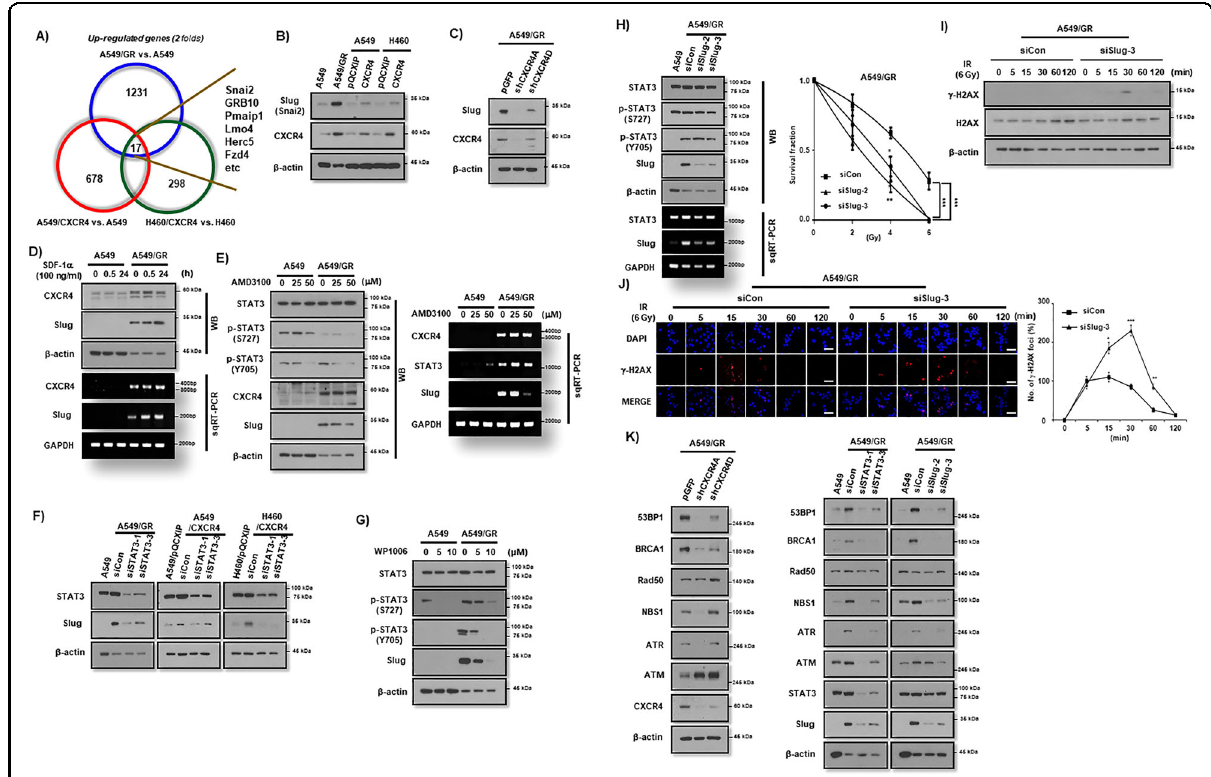
Fig. 5 Upregulation of Slug is responsible for the IR resistance in CXCR4 overexpressed NSCLC cells. A Microarray of NSCLC cells for extracting commonly elevated genes between the groups described in the Figure. B – G Western blot ( B – H ) and RT-PCR ( D , E , and H ) analysis in NSCLC cells overexpressing CXCR4 ( B ), transfected with shCXCR4 ( C ), treated with SDF-1 α ( D ), pretreated with AMD3100 ( E ), transfected with siSTAT3 ( F ), pretreated with WP1066 ( G ), and transfected with siSlug ( H , left). Antibodies and RT-PCR primer used in the experiments are described in the Figure. β -actin and GAPDH were used as a loading control for Western blot and RT-PCR, respectively ( H , right). IR clonogenic survival assay of A549/GR cells transfected with control siRNA (siCon) or siRNA against Slug (siSlug-2 and siSlug-3). I Western blot analysis of A549/GR cells transfected with siCon or siSlug-3. Cells were seeded in complete medium. Next day, cells were exposed to IR at 6 Gy, lysed in lysis buffer at various time points indicated in the Figure, and probed with antibodies indicated in the Figure. β -actin was used as a loading control. J γ -H2AX foci assay of A549/GR cells transfected with siCon or siSlug-3. ICC images were obtained from cells exposed to 6 Gy of IR at the indicated time points described in the Figure using γ -H2AX antibody (left). Graphs represented statistical analysis of ICC data (right). Nuclei were counterstained with DAPI (blue). * P < 0.05, ** P < 0.01, *** P < 0.005. White bar: 20 μ m. K Western blot analysis of A549/GR cells transduced with lentiviral pGFP or shCXCR4 (left) and transfected with siCon, siSTAT3, or siSlug (right). Antibodies used are described in the